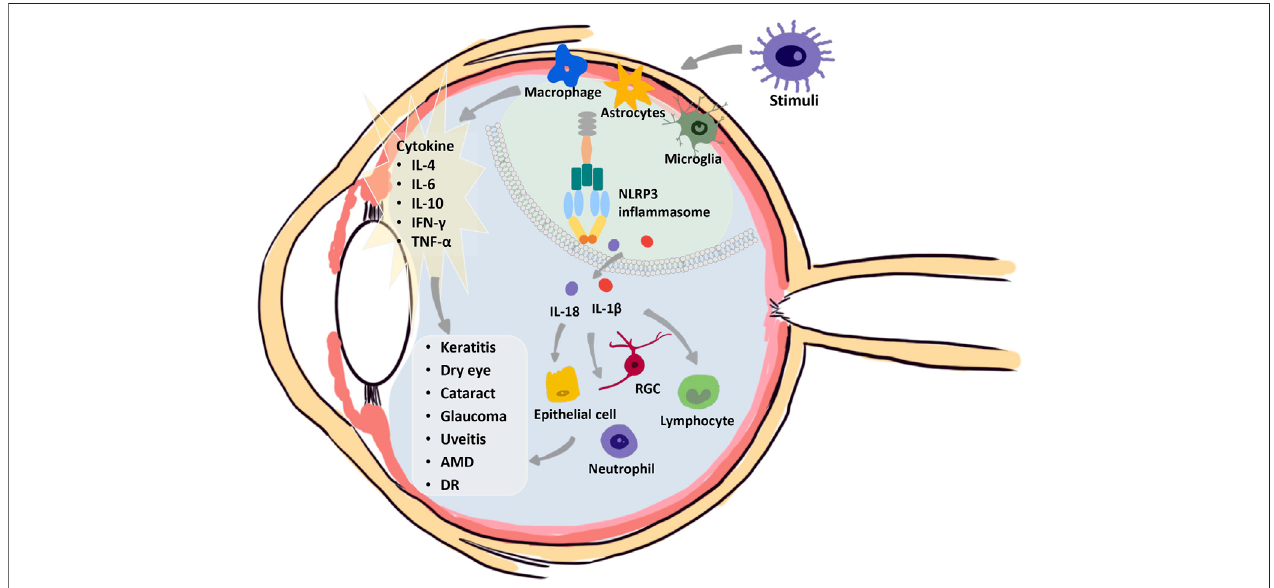
FIGURE3| CrucialroleoftheNLRP3in fl ammasomeinthepathogenesisofeyediseases.TheNLRP3in fl ammasomemediateseyein fl ammationoccurrenceunder various stimuli, such as bacterial and viral infections, desiccating stress, autoimmune factors, drusen, and complement proteins. Activation of immune cells results in a cascade of massive in fl ammatory cytokines, including IL-4, IL-6, IL-10, IFN- γ , and TNF- α . Meanwhile, NLRP3 in fl ammasome activation occurs in activated macrophages, astrocytes,andmicroglia,whichdrives thesecretion ofIL-1 β and IL-18torecruitin fl ammatorycellsand induce thedamageorcelldeathofdifferent cells. Multiple damage factors induce various injuries in the different ocular tissues, leading to keratitis, dry eye, cataracts, glaucoma, uveitis, age-related macular degeneration, or diabetic